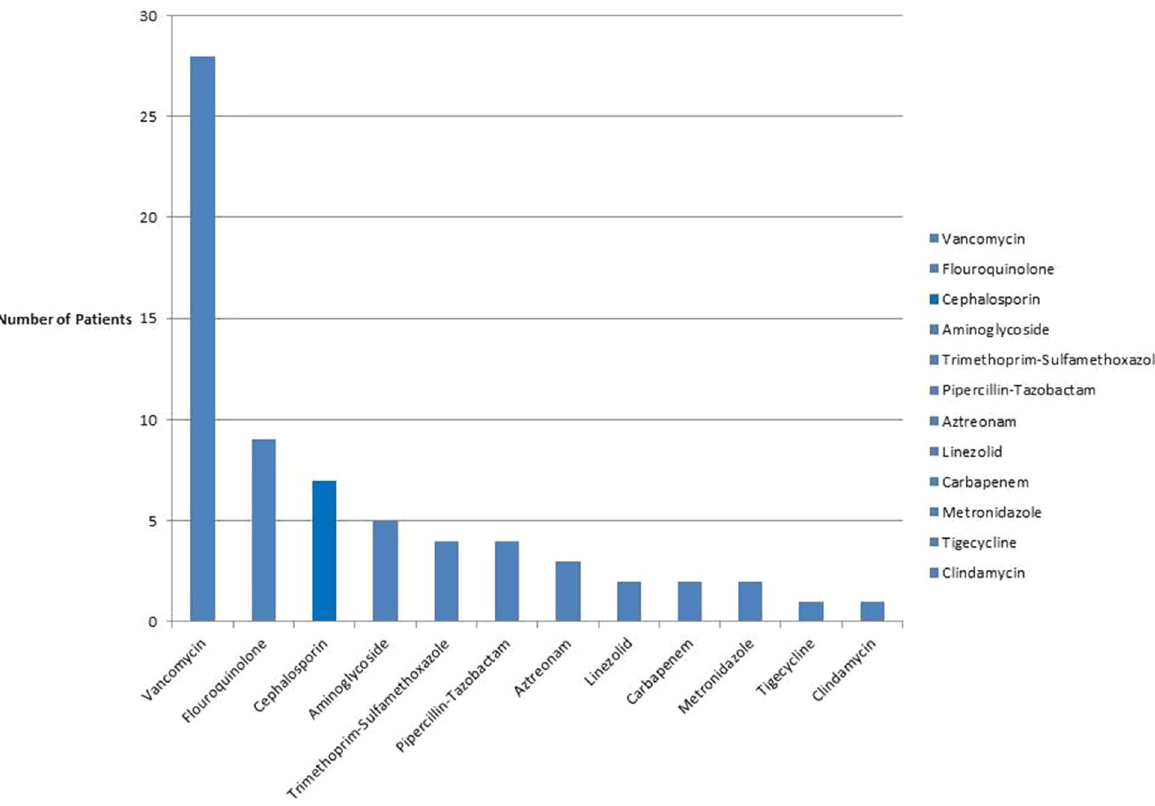
Table 1 Antimicrobial usage in the intensive care unit in patients with reported penicillin